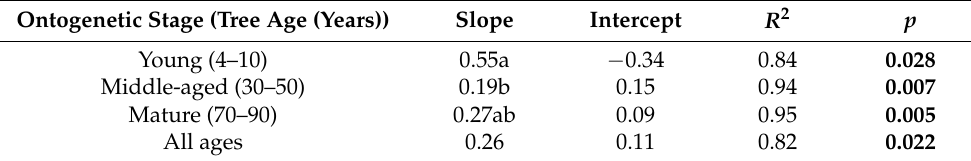
Table 3. Standardized major axis (SMA) analysis of root exudation rate (RE) and respiration rate (RR) in Fraxinus mandshurica at different tree ages ( n =